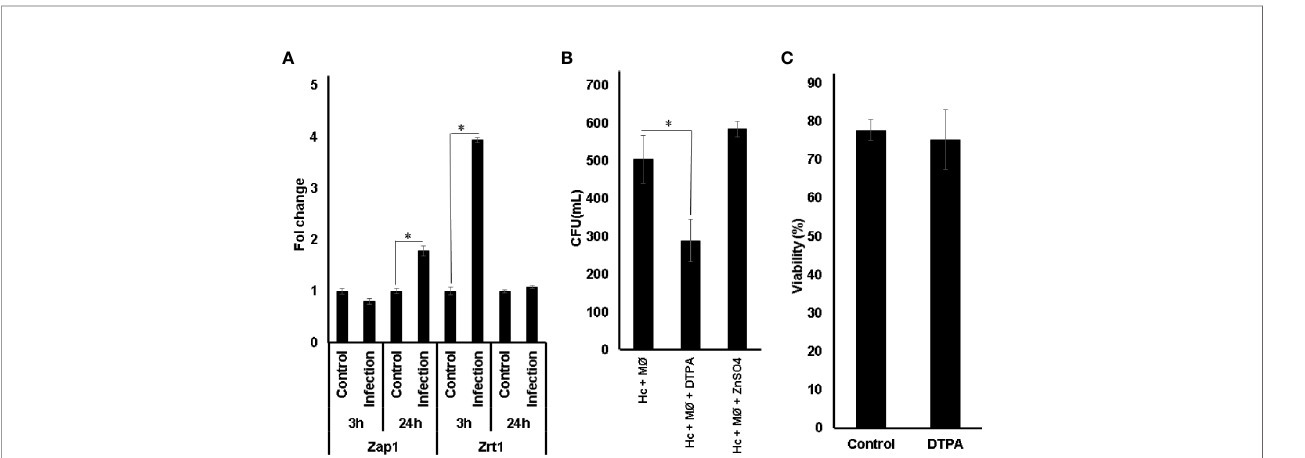
FIGURE 3 | In fl uence of Zn availability in H. capsulatum survival in macrophages. (A) Relative expression of Zap1 and Zrt1 in H. capsulatum during infection overtime. (B) Fungal burden of macrophages treated with (Hc + MØ), ZnSO4 (Hc + MØ + ZnSO4), and DTPA (Hc + MØ + DTPA) conditions. Control: H. capsulatum incubated in macrophage medium; Infection: macrophages infected with H. capsulatum yeasts. (C) Viability of macrophages in RPMI medium was measured by trypan blue dye. Statistical analysis was performed using t-test, one-way ANOVA, and the Tukey multiple comparison test with *p ≤ 0.05. All experiments were carried out in